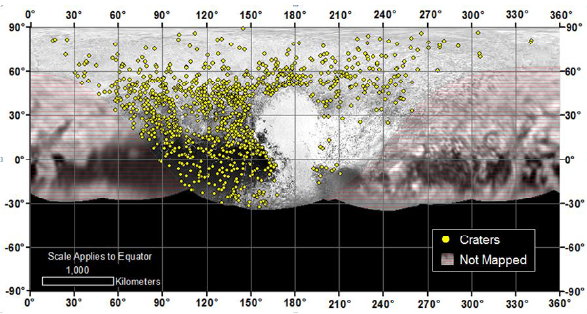
Figure 2. Crater Distribution Map of Pluto. Locations of more than 1,000 craters mapped on Pluto by NASA's New Horizons mission indicate a wide range of surface ages, which likely means that Pluto has been geologically active throughout its history (Singer et al., 2016).